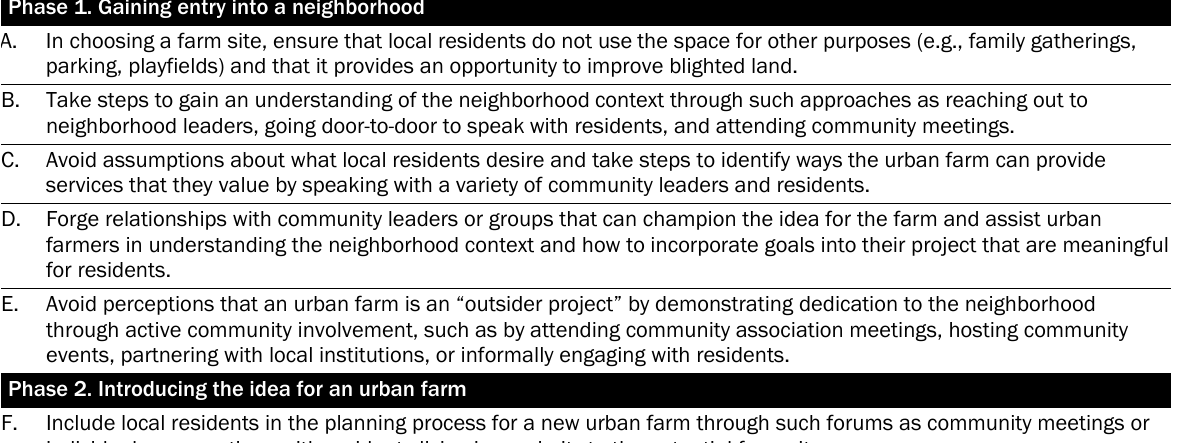
Table 3. Summary of Recommendations for Gaining Community Buy-in for Urban Farming Phase 1. Gaining entry into a